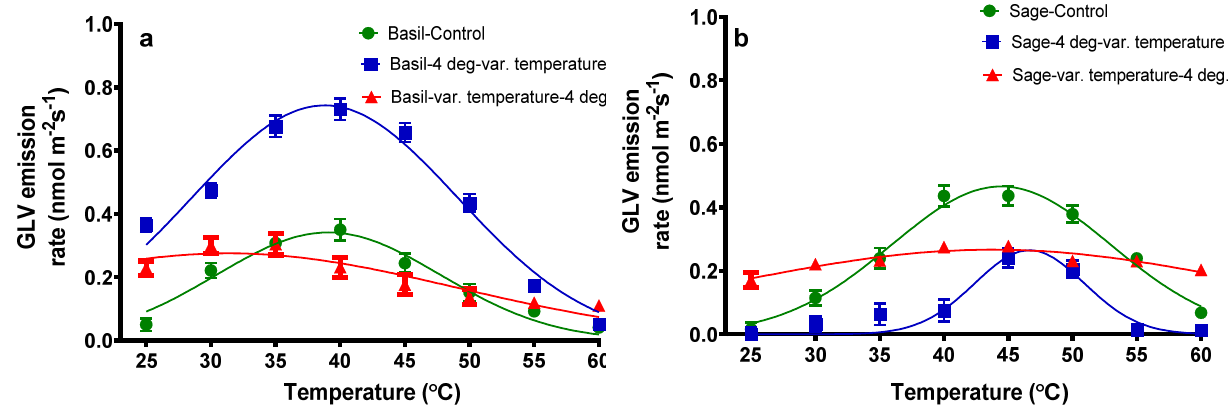
Figure 3. The emission rate of green leaf volatile compounds (GLV) from basil plants ( a ) and sage plants ( b ); plants were subjected to different temperatures.